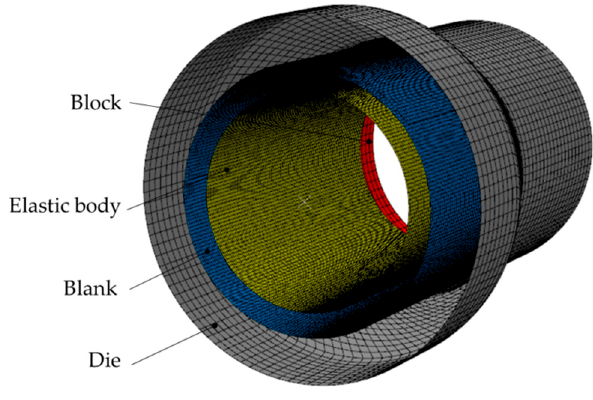
Figure 7. Finite element model.